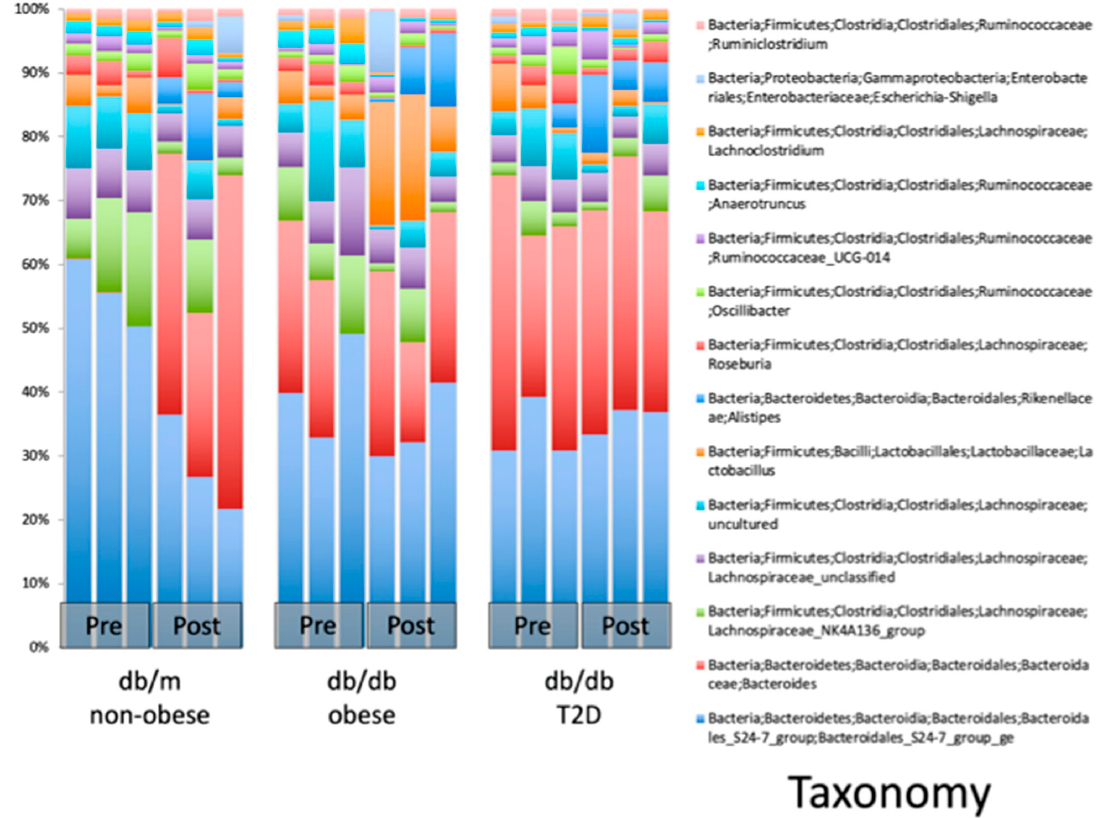
Figure 3. Taxonomic classification of the most abundant species in each mouse. Each column represents the microbial community within a single mouse. Post WBV, db / m mice showed an increase in microbes in the genera Bacteroides and Alistipes. The db / db obese mice showed an increase in microbes in the genera Lactobacillus and Alistipes. The db / db type 2 diabetes mellitus (T2DM) mice also showed an increase of microbes in the genus Alistipes. Table 1. Taxa with the most significant increases post WBV . Alistipes increased by 17 times. This analysis combined the pre-/post-WBV results from mice in all cages.